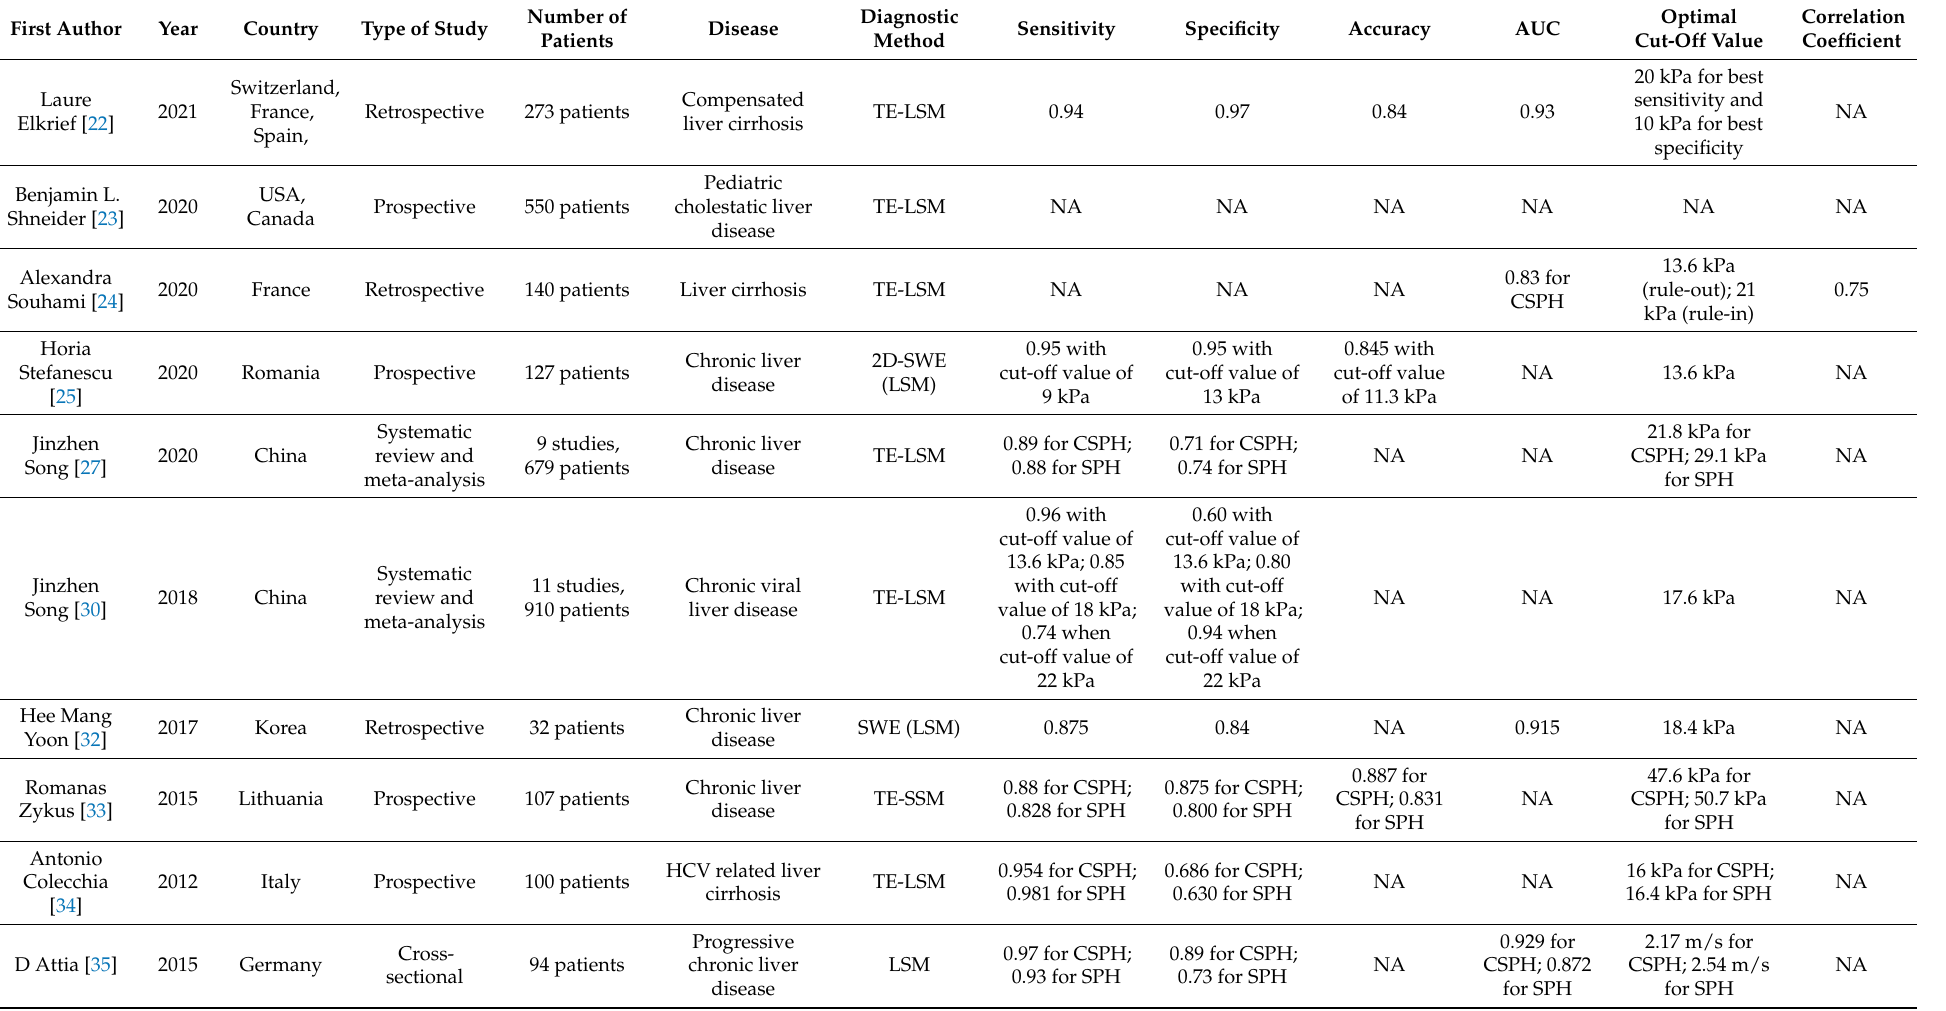
Table 1. Basic characteristics and diagnostic efficacy of LSM in assessing portal